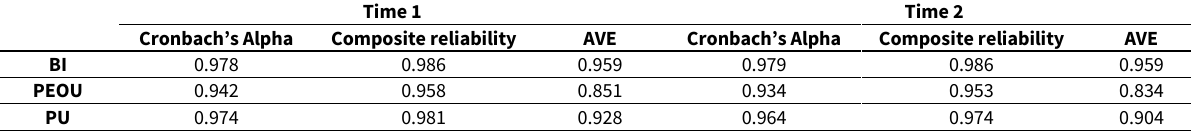
Table 4. Convergent